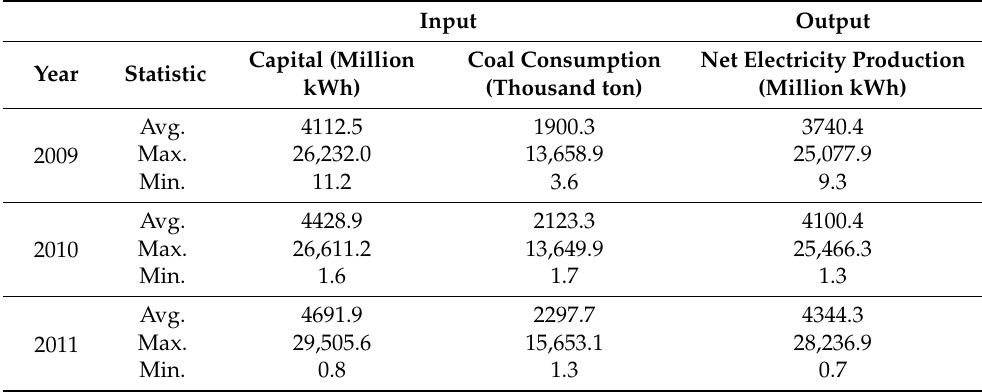
Table 1. Descriptive statistics for the inputs and output of this study.